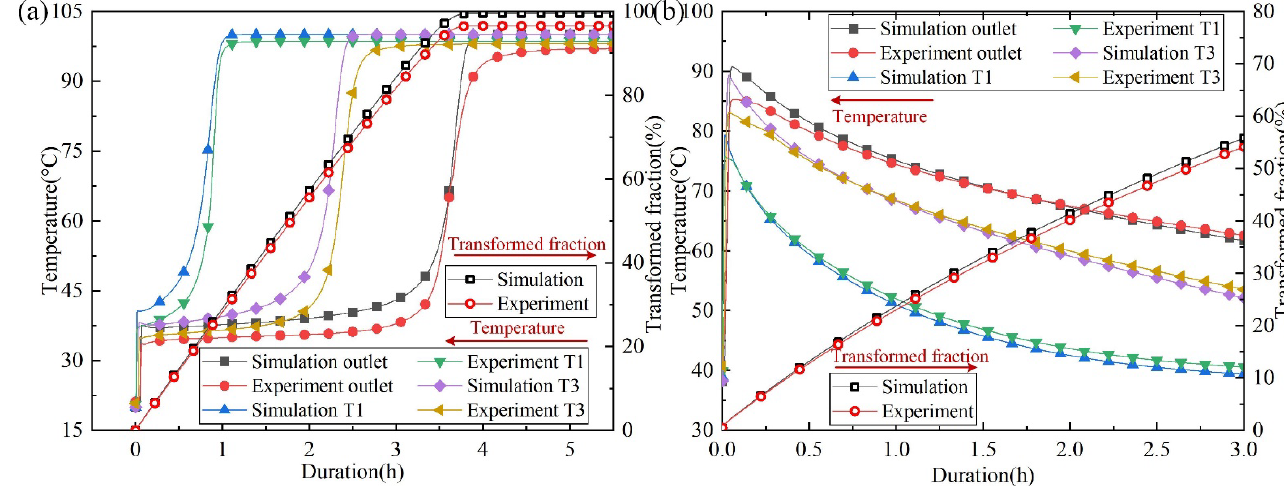
Figure 5. Comparison of experimental and numerical simulation results for ( a ) the charging and ( b ) discharging process of the fixed-bed reactor.